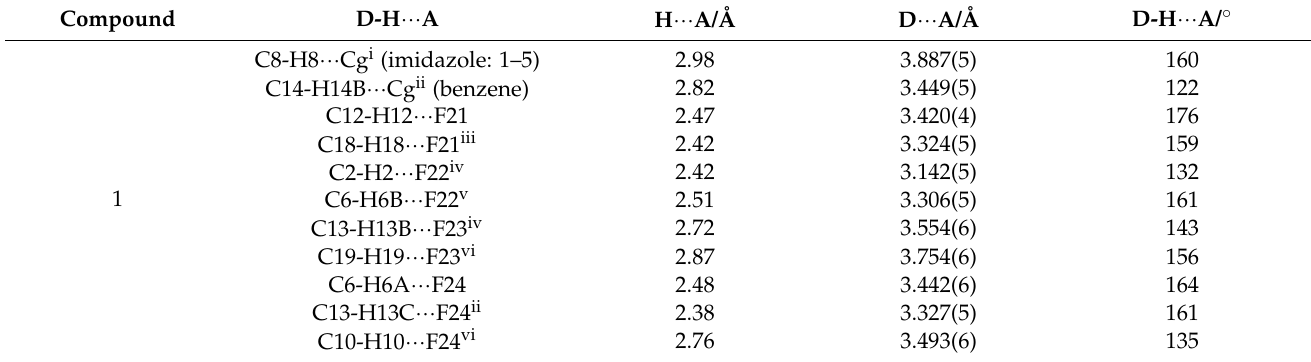
Table 2. Hydrogen bonding parameters for complexes 1–3 .